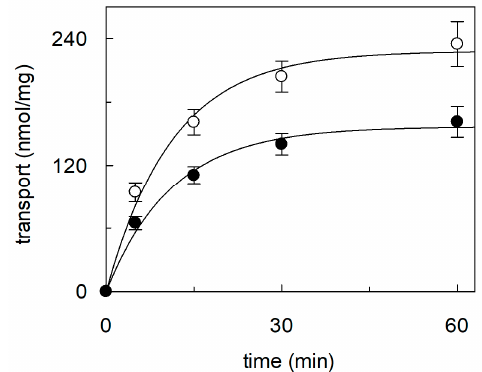
Figure 5. Effect of removal of CHS after addition to proteoliposomes . The recombinant OCTN1 was reconstituted in liposomes as described in Section 4.5. except that in the presence of 8.3% CHS corresponding to 83 µg CHS/mg total lipids. Proteoliposomes were incubated in the absence ( ○ ) or in the presence of 10 mM M β CD ( ● ). Transport was started adding 0.1 mM [ 14 C]-TEA at time zero to proteoliposomes and stopped at the indicated times as described in Section 4.7. Time course data were interpolated in a first order rate equation. The values are means ± SD from three different experiments. To confirm the CHS removal after M β CD treatment, CHS concentration was measured (see the method in Section 4.6) and compared to that of the untreated sample. The initial concentration of CHS of 8.3% ( 83 µg CHS/mg total lipids) was reduced to 5% ( 50 µg CHS/mg total lipids) corresponding to